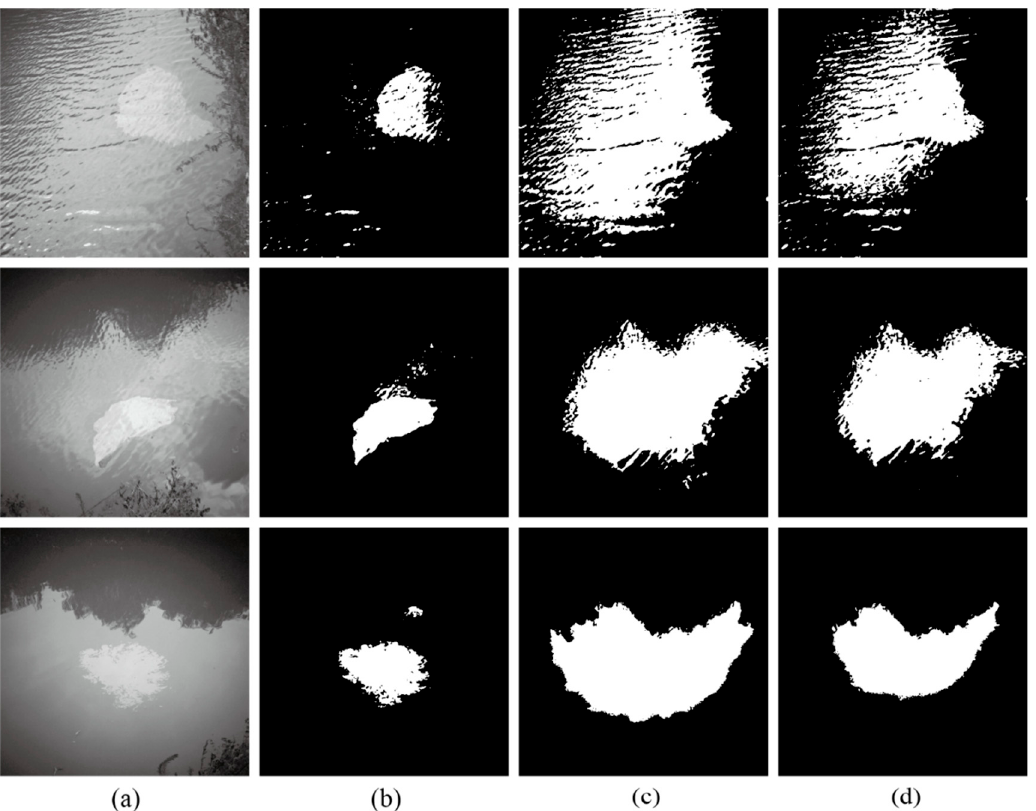
Figure 8 . Examples of segmentation results. ( a ) The original images; ( b ) the results after GBS, ATE, and LFTM; ( c ) the results using only local fuzzy thresholding methodology (LFTM) with 3 centroids; and ( d ) the results using only LFTM with 4 centroids.